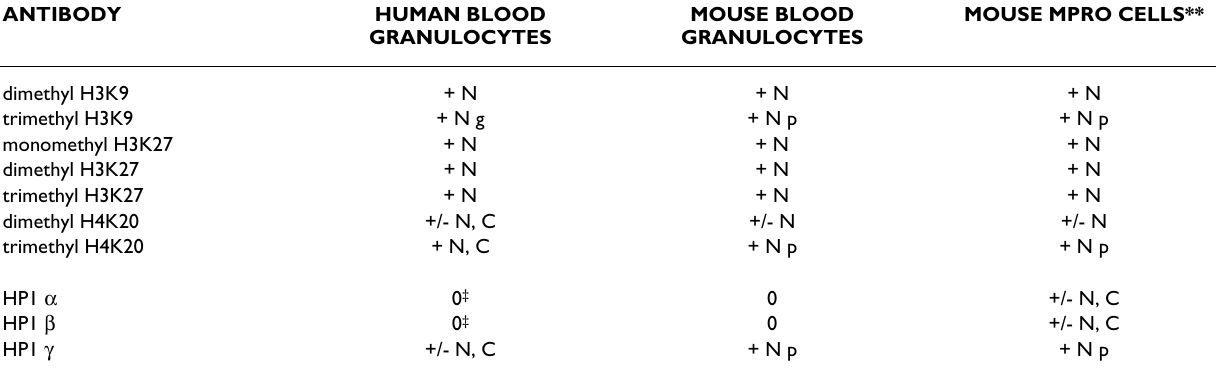
Table 1: Summmary Of Granulocyte Immunochemistry*.